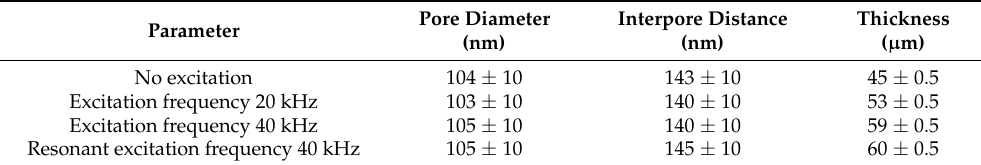
Table 3. Pore diameter, interpore distance, and thickness of AAO nanoporous membranes.